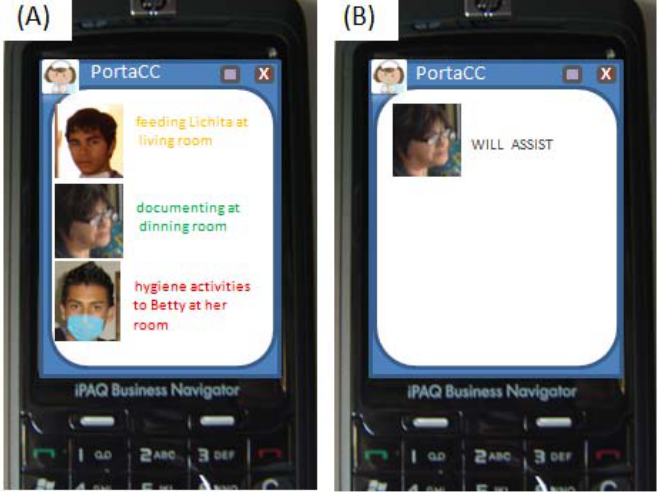
Figure 18. Visual-Tactile Mechanism Notifications: ( A ) Phase 1: Caregivers’ Context; ( B ) Phase 2: Decision